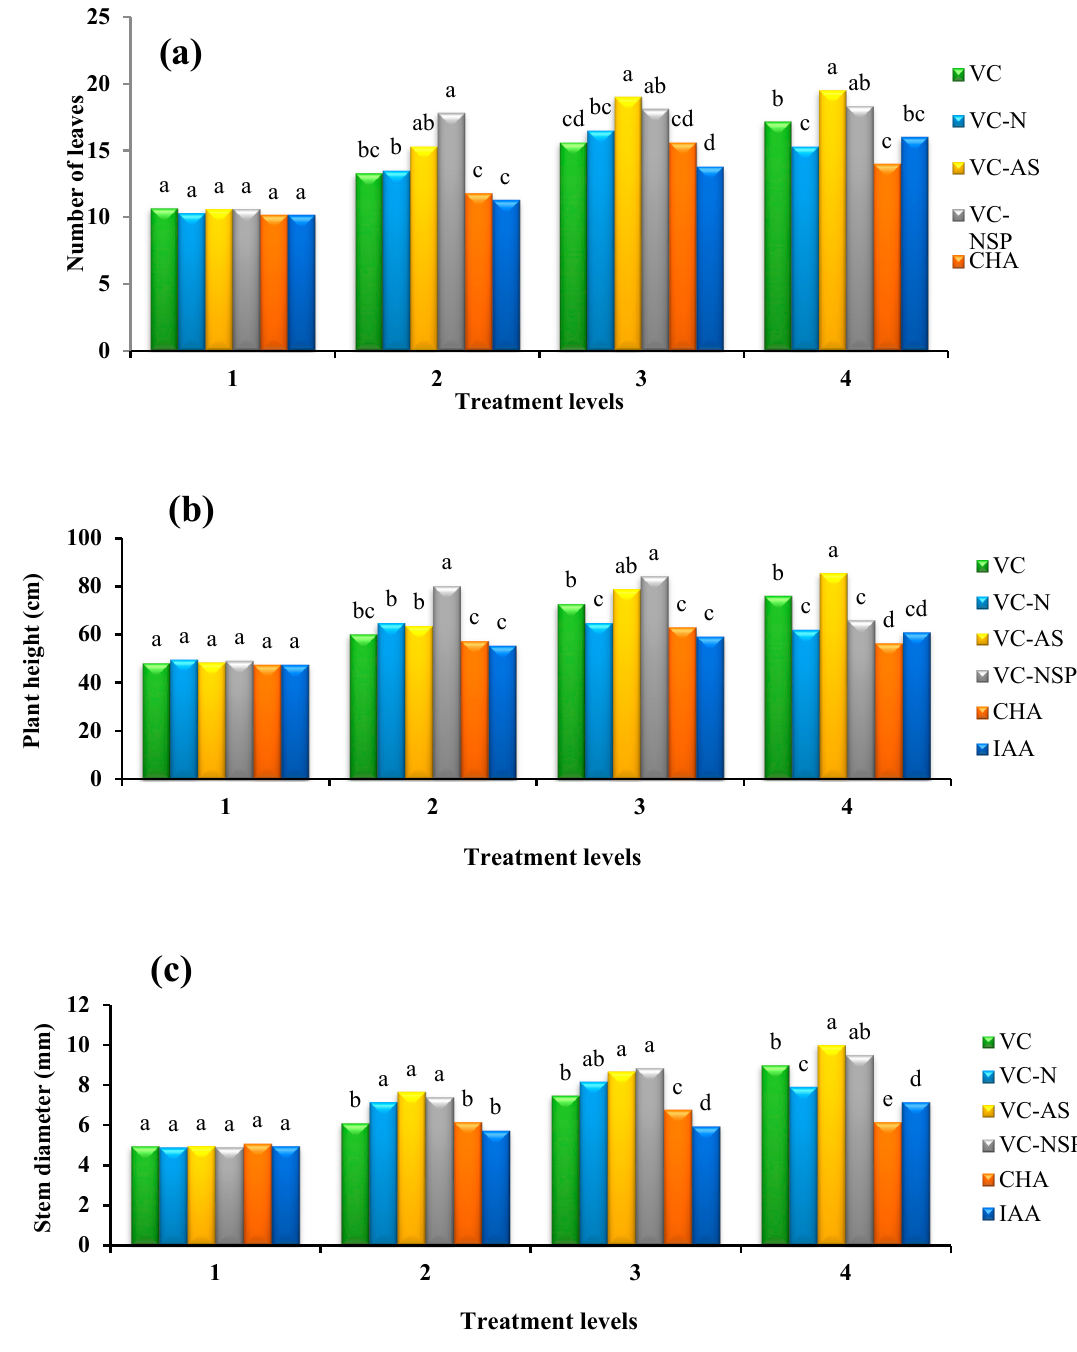
Figure 1. Comparison of average soil application of experimental treatments on number of leaves ( a ), plant height ( b ) and stem diameter ( c ) at treatment levels (levels 1, 2, 3 and 4 for VC, VC-N, VC-AS and VC-NSP treatments of 0, 1, 2 and 3% VC, 0, 200, 400 and 600 mg of CHA per kg of soil and 0, 10 − 6 , 10 − 5 and 10 − 4 molar IAA). Different letters in each figure show significant difference at p ≤ 0.05 by Duncan multiple range test. VC, VC without enrichment; VC-N, VC enriched with 1% nitrogen; VC-NSP, VC enriched with 1% nitrogen, 1% sulfur, and 1% phosphorus; VC-AS, VC enriched with Azotobacter chroococcum (21Az) + Pseudomonas fluorescens (Ps 59); CHA, Commercial humic acid; IAA, Indole-3-acetic acid.